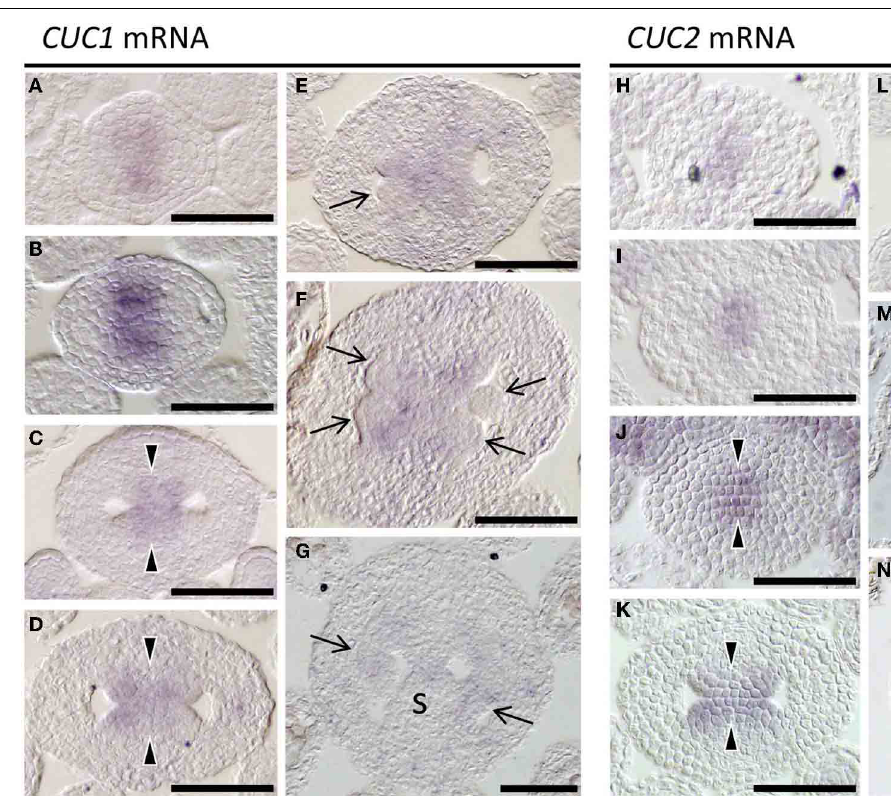
FIGURE 3 | Expression of CUC1 and CUC2 . In situ hybridization on transverse sections of developing wild type (L er ) gynoecia regenerated from calli. Probed with CUC1 (A–G) and CUC2 (H–N) . Sections are prepared from